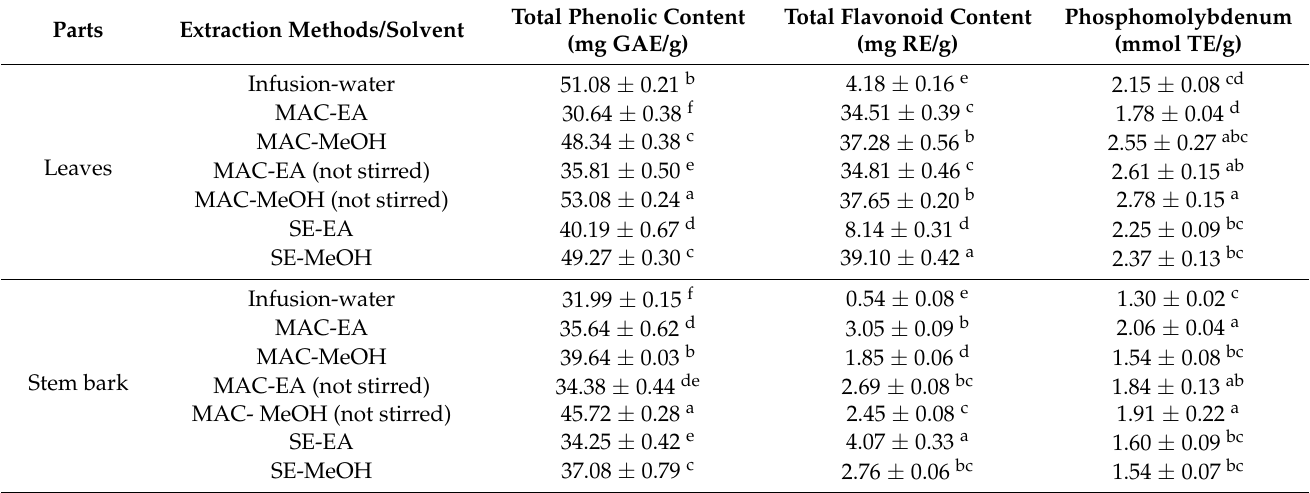
Table 1. Total bioactive compounds and total antioxidant capacity (by phosphomolybdenum assay) of the studied extracts